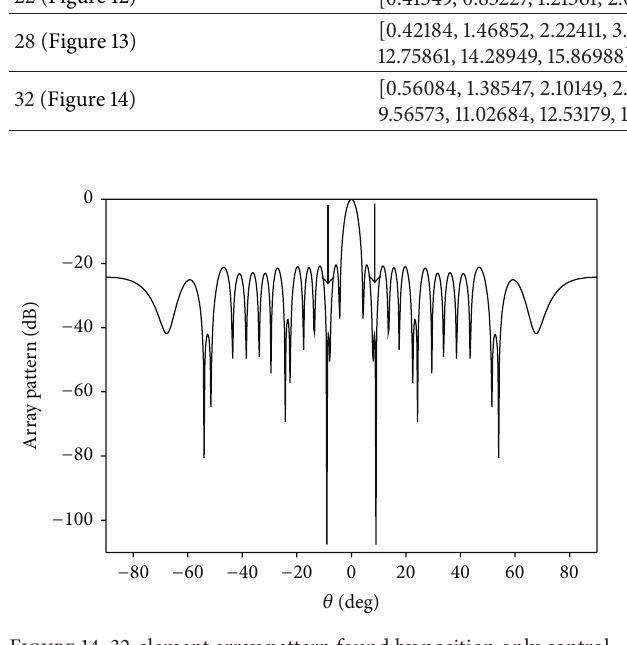
Figure 14: 32-element array pattern found by position only control with one imposed null at 9 ∘